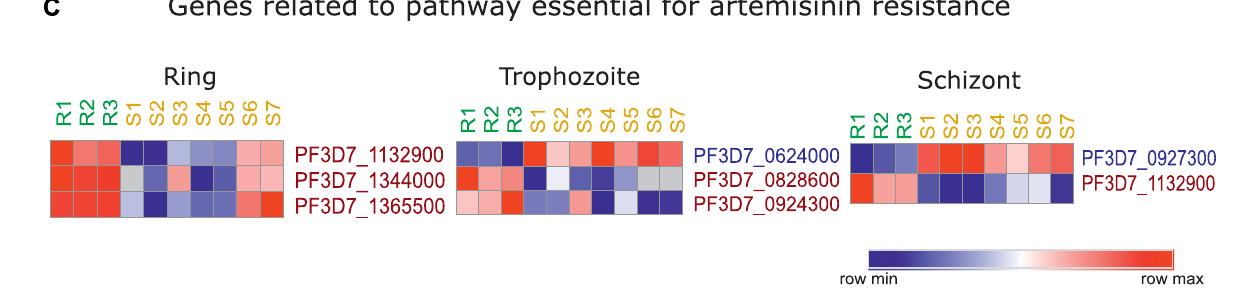
FIGURE5| Artemisininresistancetranscriptomeforhemoglobincatabolismrelatedgenesandmetabolicgenes.Heatmaprepresentingthestagespeci fi ctrendsin deregulation of expression of key genes implicated in (A) glycolysis and pentose phosphate pathway, (B) hemoglobin catabolism, and (C) genes related to pathway important for artemisinin resistance. The heatmap is generated from the expression values from the study of Mok et al. (2011). The list of genes themselves has been selected on the basis of deregulation of these genes across artemisinin-resistant vs. artemisinin-sensitive isolates in this and at least one other transcriptomic dataset reviewed in this study. R1 – R3 represent the three artemisinin-resistant isolates, whereas S1 – S7 represent the artemisinin-sensitive isolates.